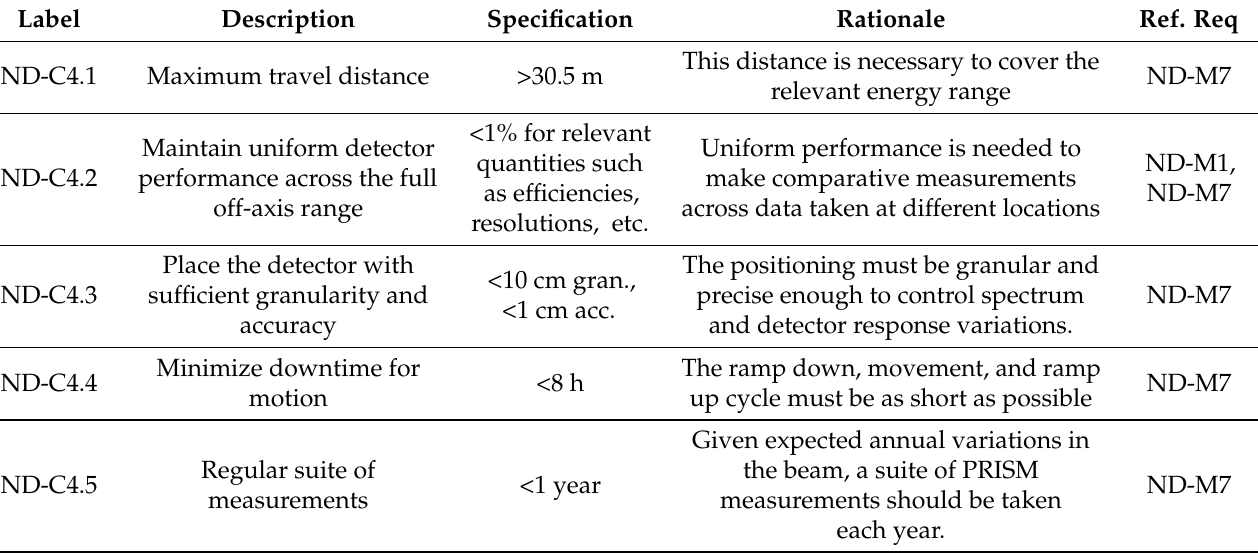
Table 7. Capability requirements for DUNE-PRISM.